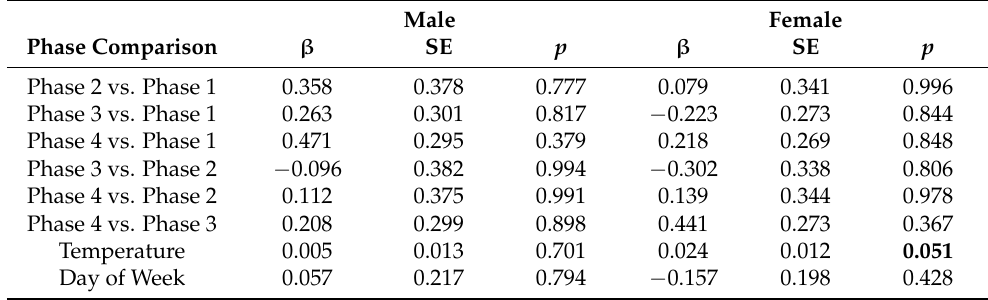
Table 7. Pairwise comparisons of glucocorticoids by phase as well as associations with temperature and day of the week (weekday vs. weekend) for each grizzly bear.